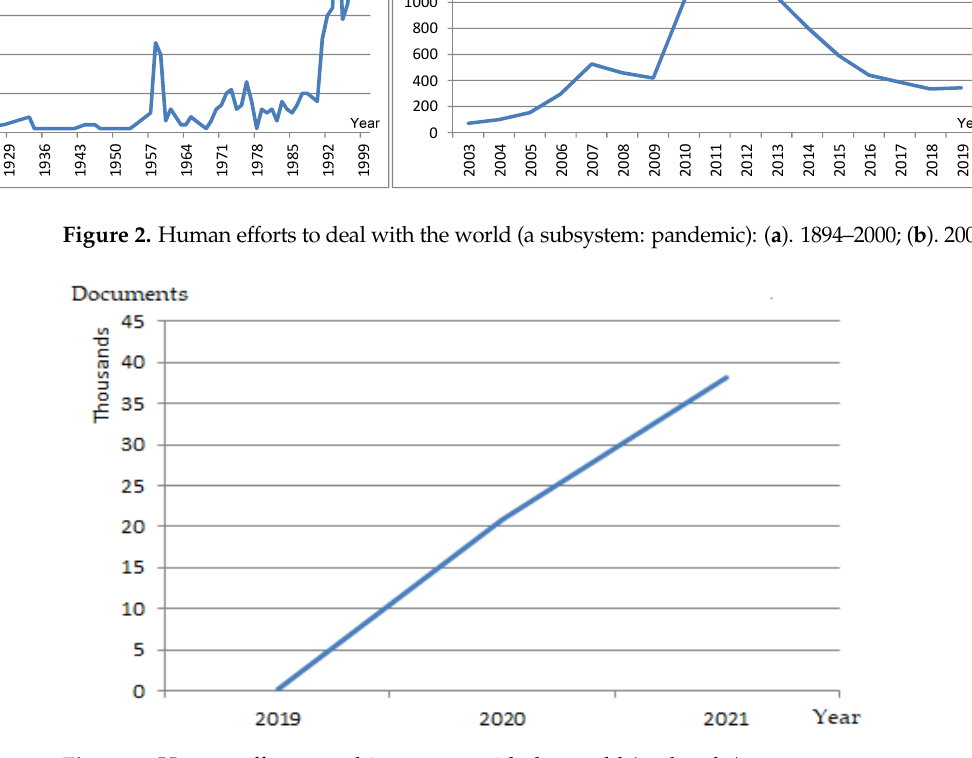
Figure 3. Human efforts to achieve peace with the world (outbreaks).